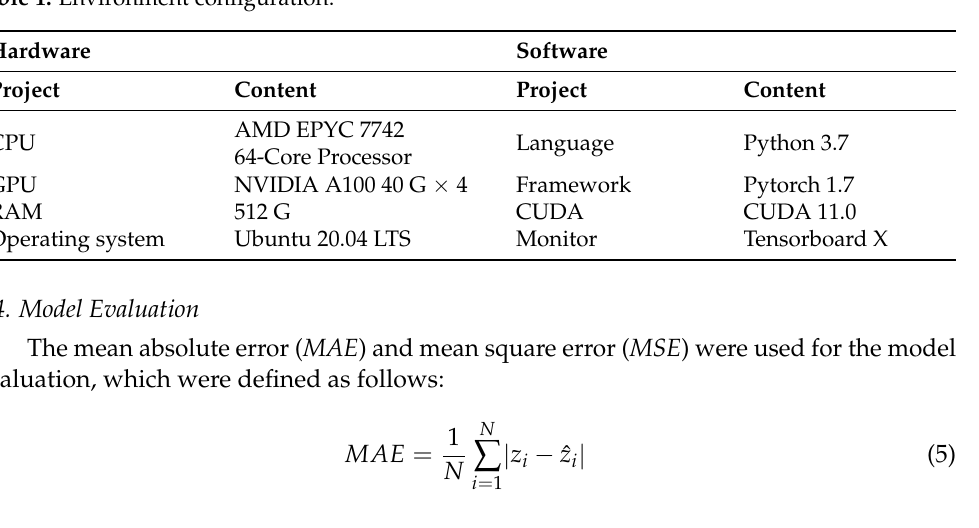
Table 1. Environment